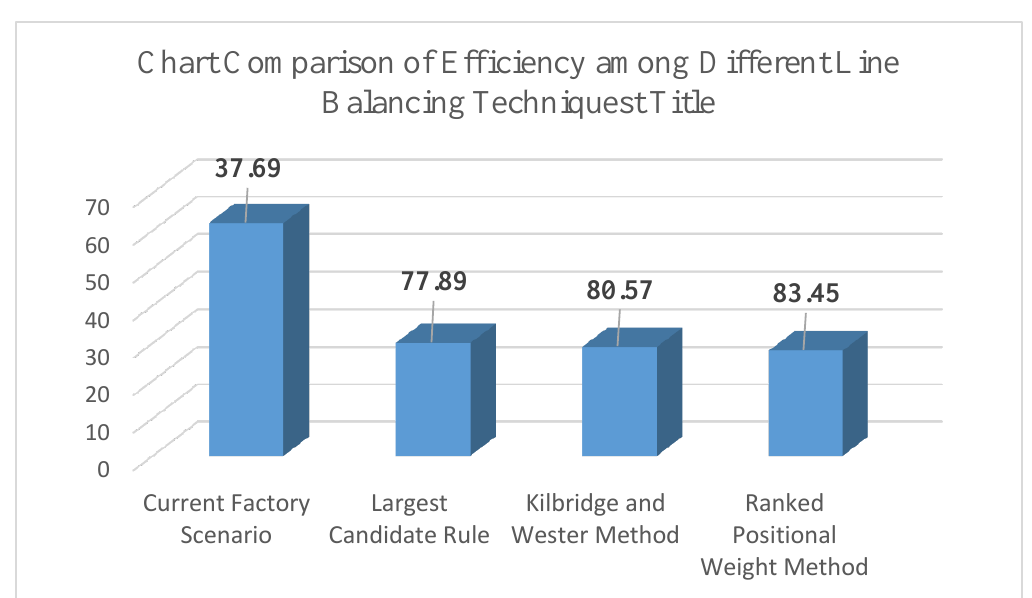
Figure 11. Comparison of efficiency among different line balancing